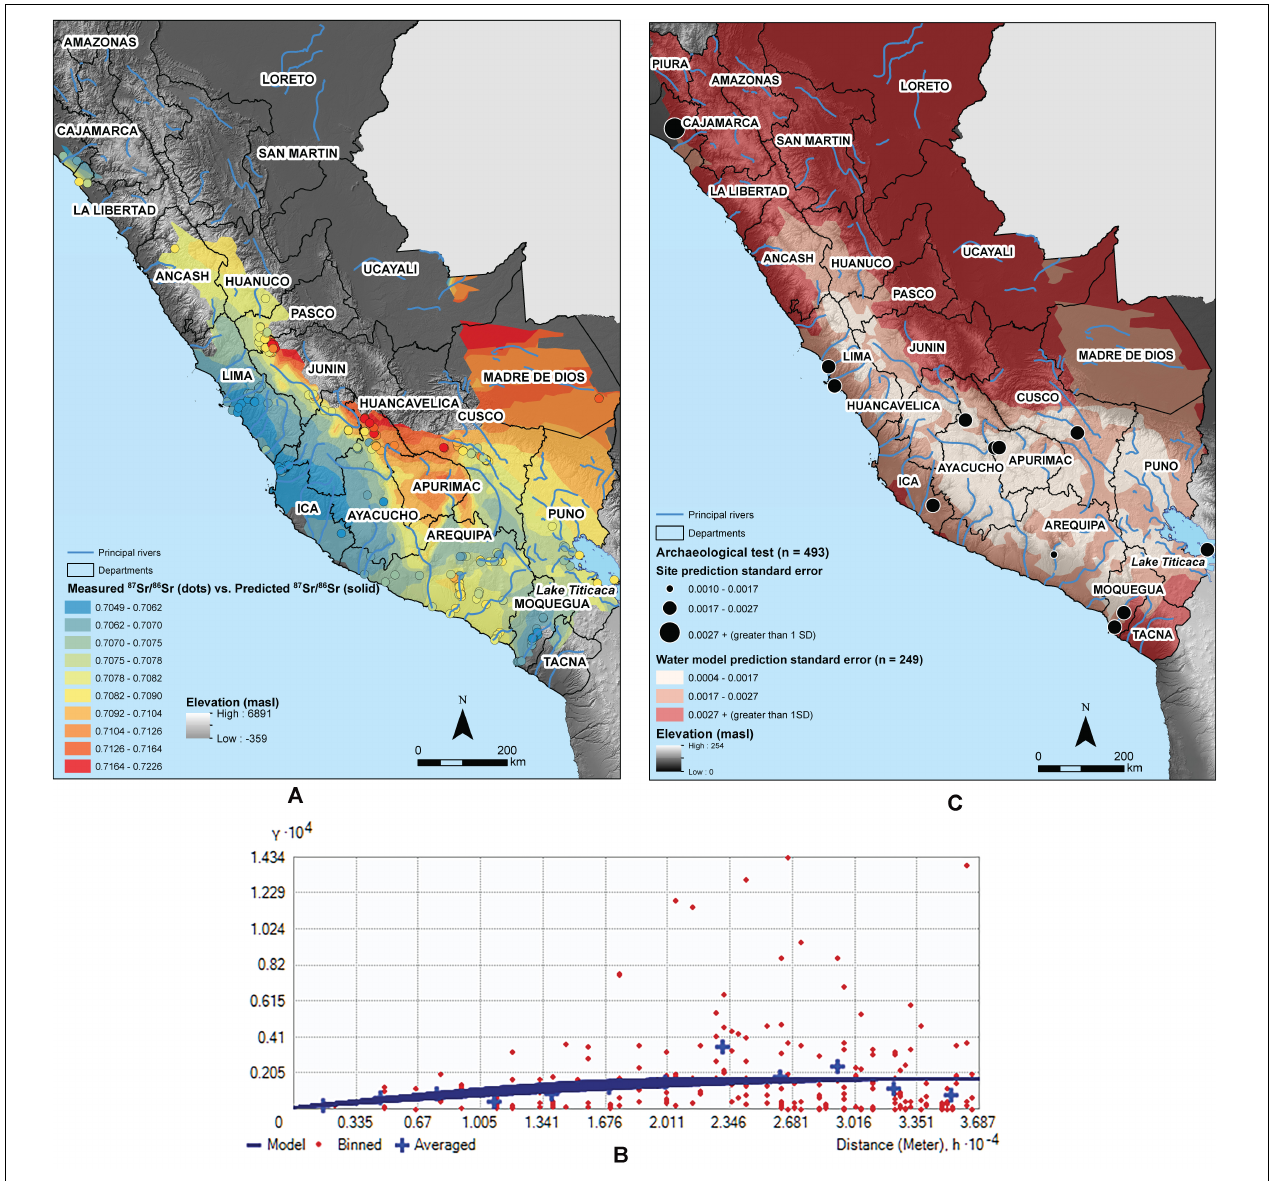
FIGURE 5 | (A) Predictive 87 Sr/ 86 Sr isoscape of the trimmed water dataset ( n = 249) (solid fill) compared to measured water 87 Sr/ 86 Sr (points in graduated colors), clipped to areas where the prediction standard error is less than 1 SD of the dataset ( SD = 0.0027), with digital elevation model (250 m ASTER) for reference. Data values are arbitrarily classified into 10 equal bins. (B) The kriging semivariogram shows the absence of spatial autocorrelation between points further away from each other than 10 km. (C) Solid fill indicates error between predicted vs. measured 87 Sr/ 86 Sr at water sampling sites ( n = 249). Predicted vs. measured 87 Sr/ 86 Sr is illustrated by increasing point size at the 12 archaeological test sites ( n = 493 test points trimmed of IQR outliers).